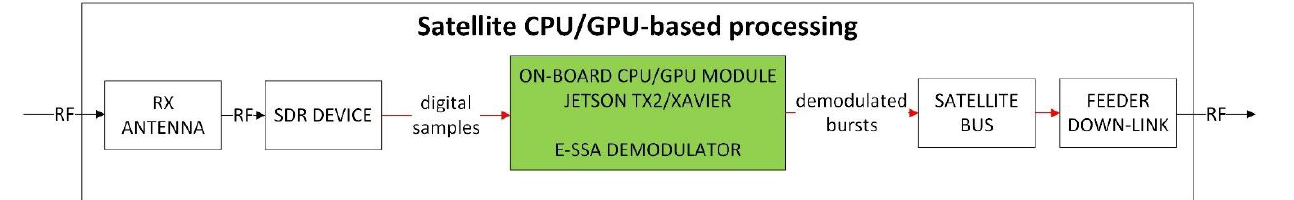
Figure 20. The satellite CPU/GPU payload implementing on-board E-SSA demodulator.